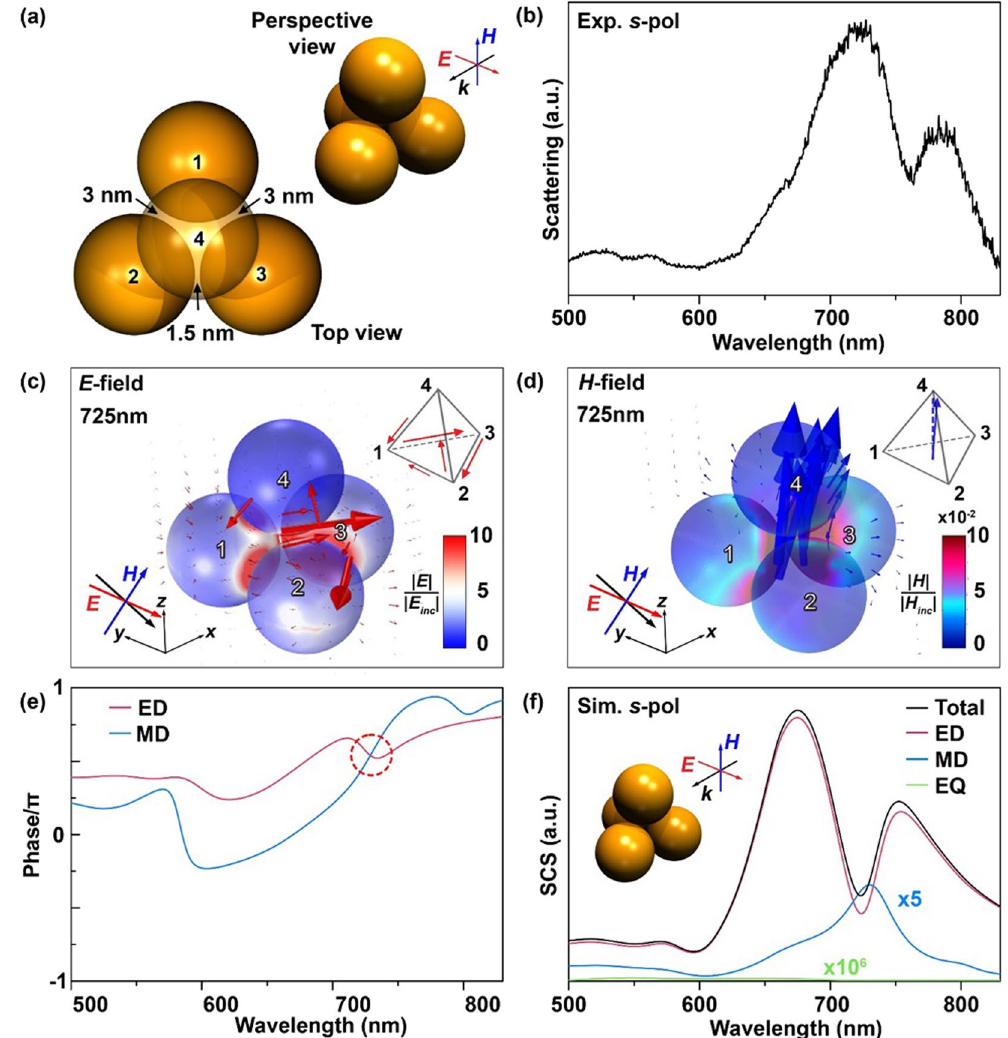
Figure 5. Electromagnetic properties of asymmetric tetrahedral cluster composed entirely of 77 nm AuNSs. ( a ) Schematic representation of the asymmetric tetrahedral cluster composed entirely of 77 nm AuNSs. The broken symmetries of the tetrahedral cluster were implemented by small deviations of two gaps from symmetric geometrical frame (1.5 nm to 3.0 nm). ( b ) The measured dark-field scattering of the asymmetric tetrahedral cluster ( a ) for s -pol illumination. The magnetic-based optical Fano resonance was clearly evidenced by a distinct dip at 760 nm. ( c ) 3D spatial distribution of the electric field at the magnetic-based Fano resonance wavelength. The red arrows of tetrahedron frames, displayed in the inset of ( c ), indicate the orientation of the induced electric field. ( d ) 3D spatial distribution of the magnetic field at the magnetic-based optical Fano resonance wavelength. The blue arrows of tetrahedron frames in the inset of ( d ) indicate the main orientation of the induced MD. ( e ) The near-field phase of ED and MD. ( f ) The theoretical SCS of ED, MD, and EQ for s